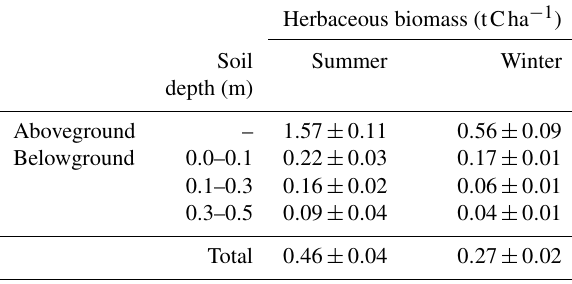
Table 4. Aboveground and belowground biomass of the herbaceous vegetation in the tree